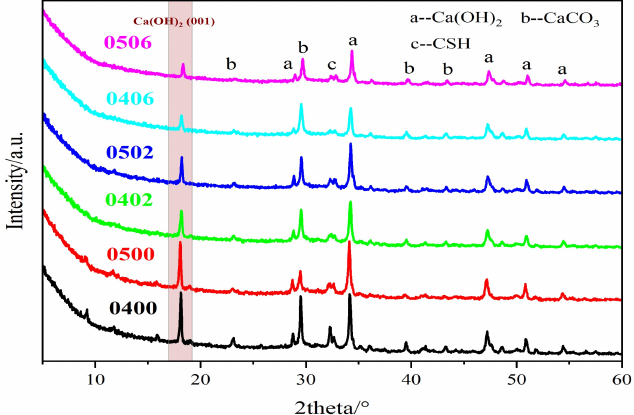
Figure 9. XRD of cement paste with PEG-600 from 0% to